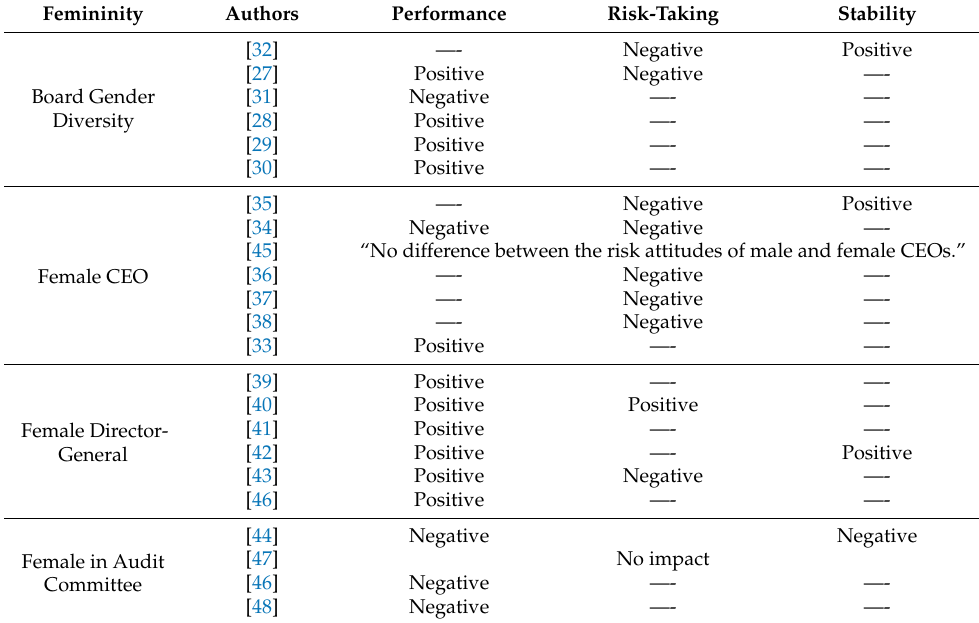
Table 1. The literature on the impact of femininity on firm financial behavior.